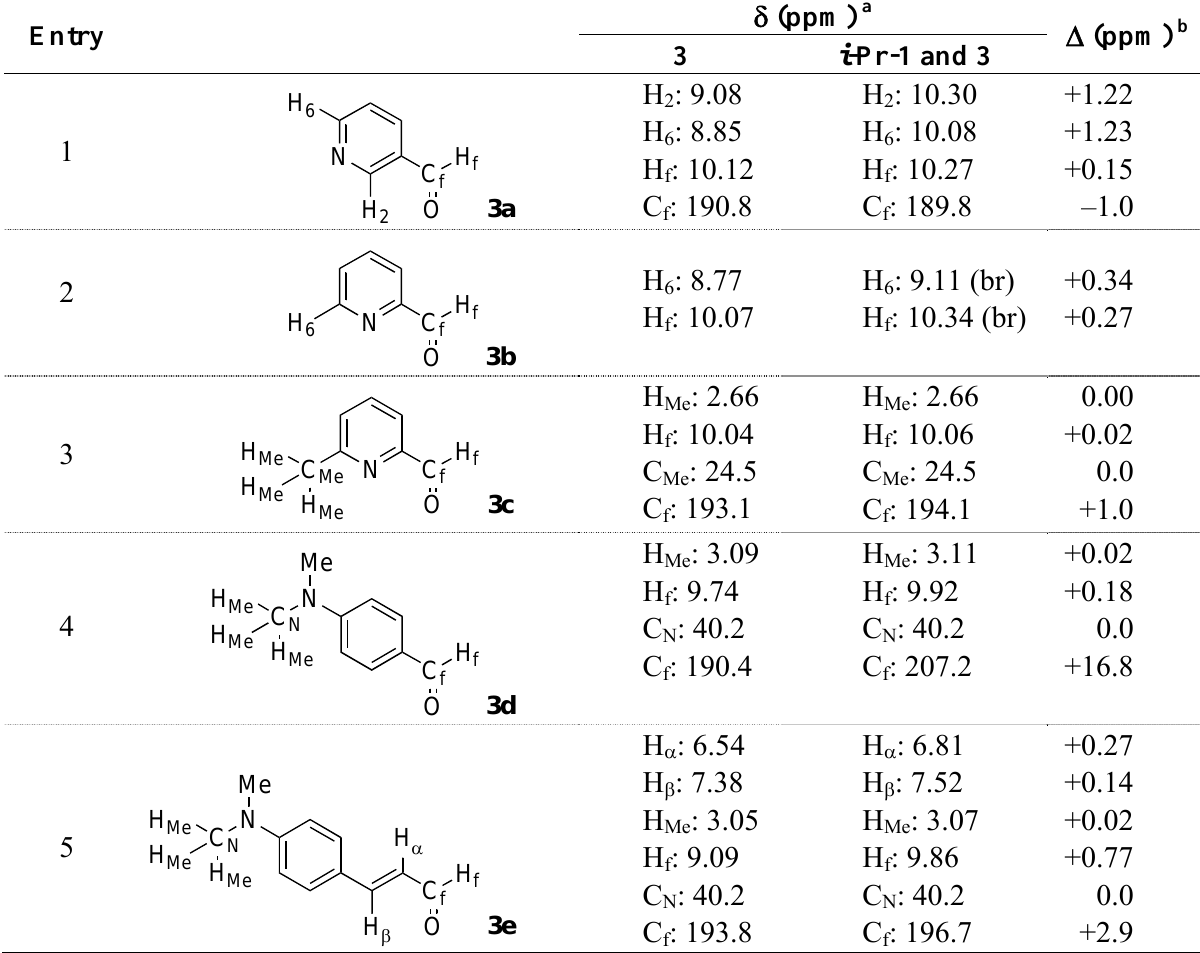
Table 1. Selected spectroscopic data for free amino aldehydes 3 and mixtures of i -Pr- 1 and 3